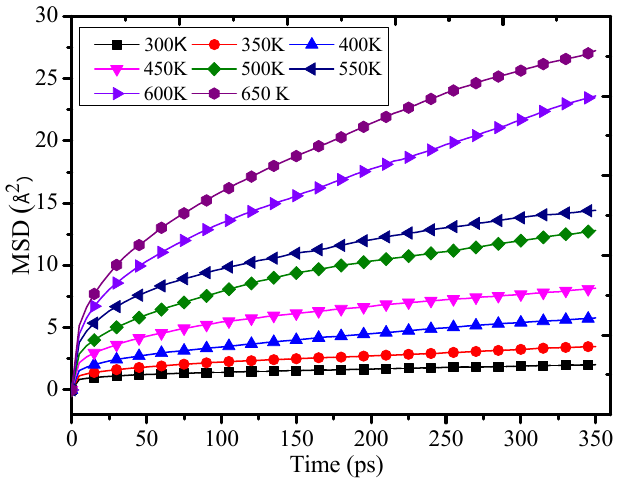
Figure 6. Mean square displacement of 12% at different temperatures.